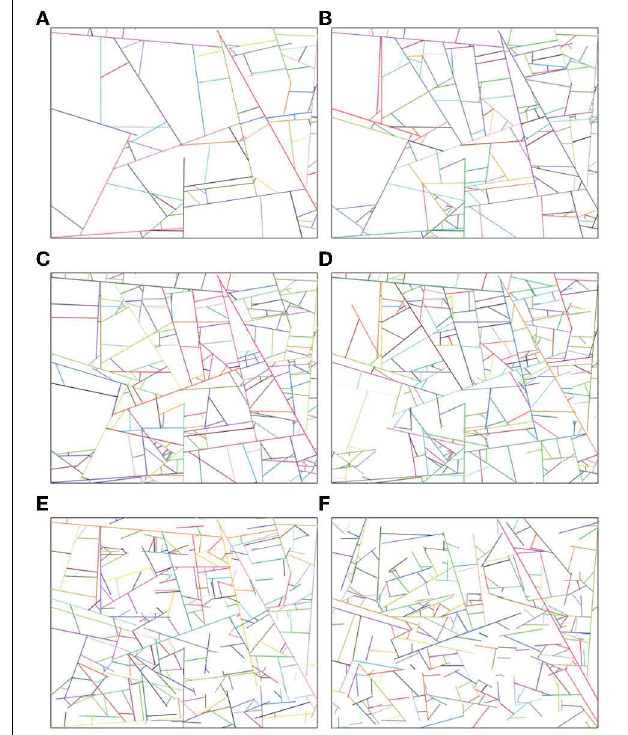
FIGURE 8 | Images taken of the growing fracture network model at different times. For all images, the continuation parameter p is set to 0 . 1. (A) Image taken after 100 time steps. (B) Image taken after 200 time steps. (C) Image taken after 300 time steps, after 300 time steps, the refreezing process keeps the number of fractures at 300. (D) Image taken after 400 time steps. (E) Image taken after 1000 time steps. (F) Image taken after 3000 time